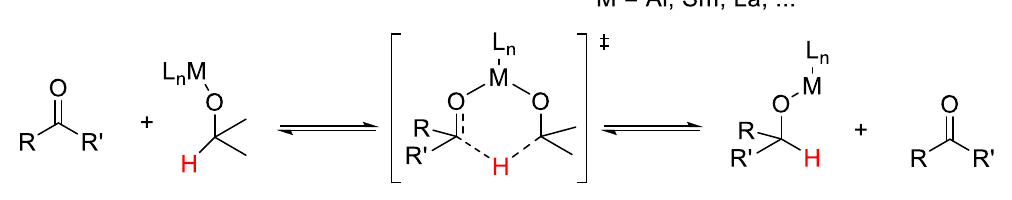
Scheme 4. Direct hydrogen Scheme 4 . Direct hydrogen transfer. Scheme 4 . Direct hydrogen transfer.